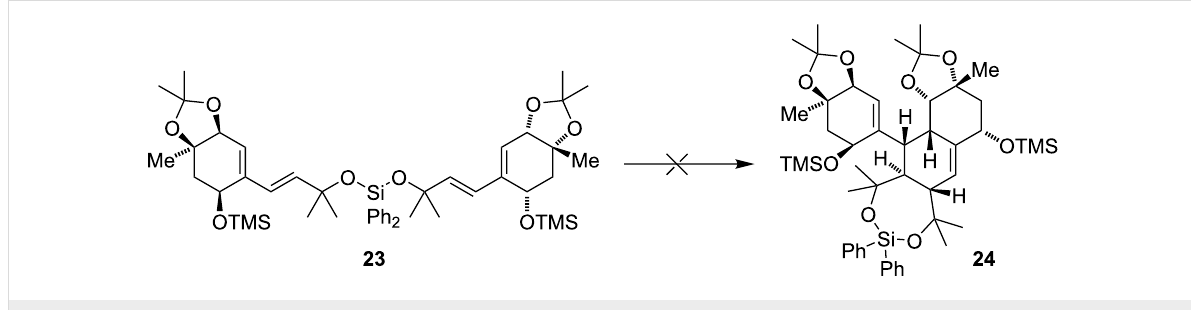
Scheme 5: Attempted intramolecular cyclization of 23 .